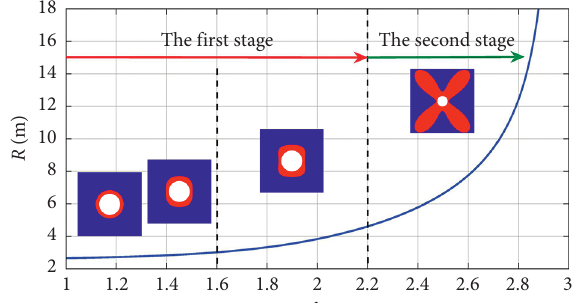
Figure 5: Variation of plastic zone radius with respect to the lateral pressure